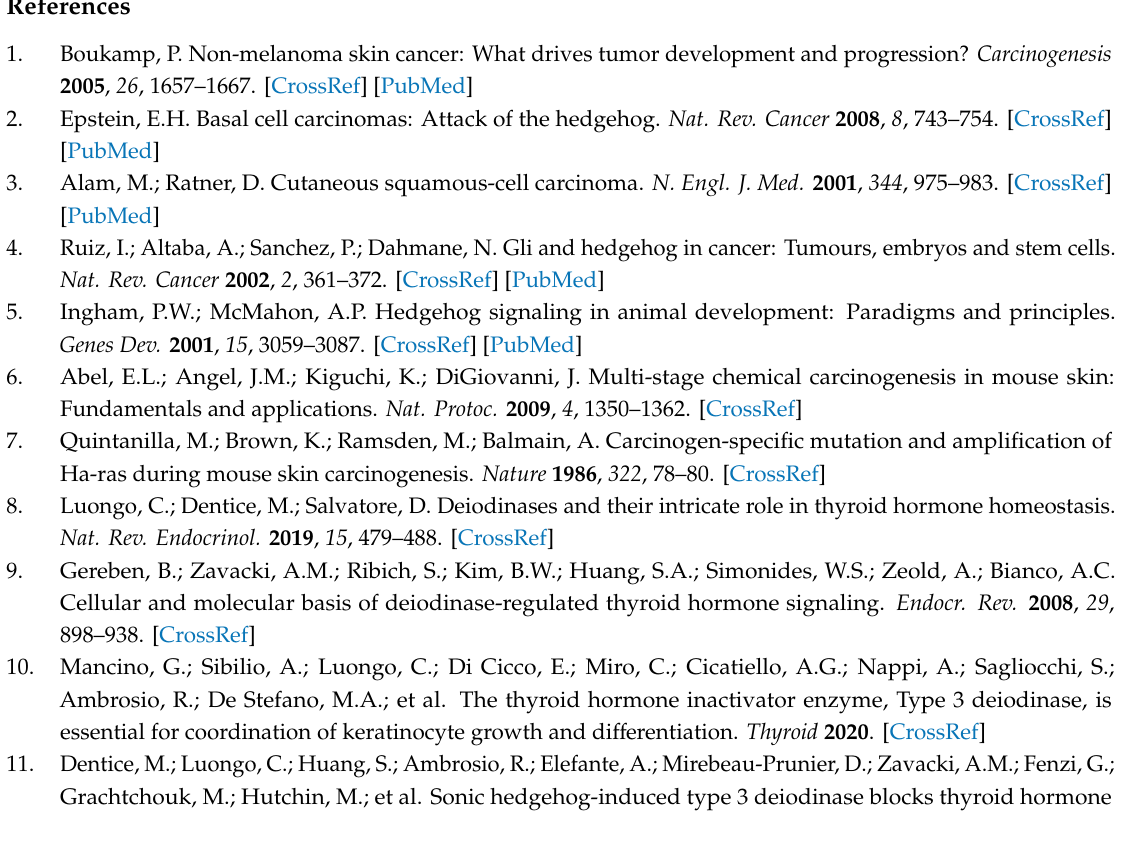
Figure S1: Strategy for the mutagenesis of Dio2 promoter, Figure S2: Strategy for the silencing of NANOG expression, Figure S3: The CD34 + cells are characterized by the expression of typical epithelial stemness genes. The mRNA levels of a panel of indicated stemness markers of epidermis were measured by real time PCR in the same experiment indicated in figure 3G and H, Figure S4: NANOG overexpression does not a ff ect cell proliferation of BCC and SCC cells, Figure S5: D2 inhibition reduces the migration and EMT of BCC cells induced by NANOG, Figure S6: Reduction of TH signaling and D2 activity attenuates EMT of SCC cells, Figure S7: Uncropped images of the blots shown in Figure 1, Figure S8: Uncropped images of the blots shown in Figure 5, Figure S9: Uncropped images of the blots shown in Figure S2, Figure S10: Uncropped images of the blots shown in Figure S4, Table S1: In silico analysis of Transcription Factor Binding Sites (TFBS) ~1.3 kb upstream from the Transcription Start Site (TSS) of Dio2 gene, Table S2. List of